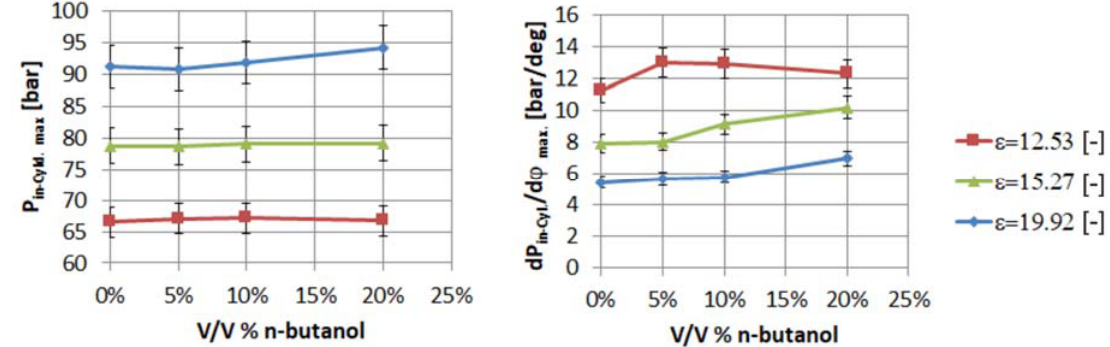
Figure 2. Maximal value of in-cylinder pressure and in-cylinder pressure changing rate over various blending rates with different compression ratios ( σ Pi ± 3.59%).